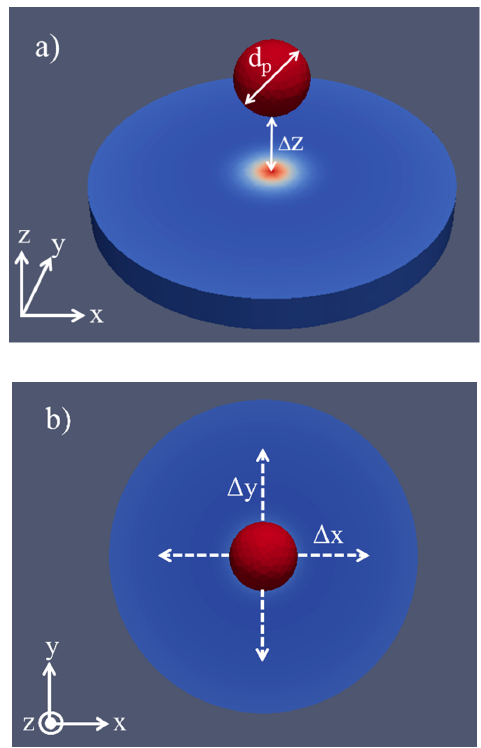
Figure 2. Simulation setup: ( a ) Variation of the label’s height and diameter. ( b ) Definition of the label’s shift in the x/y plane starting from the center of the free layer.